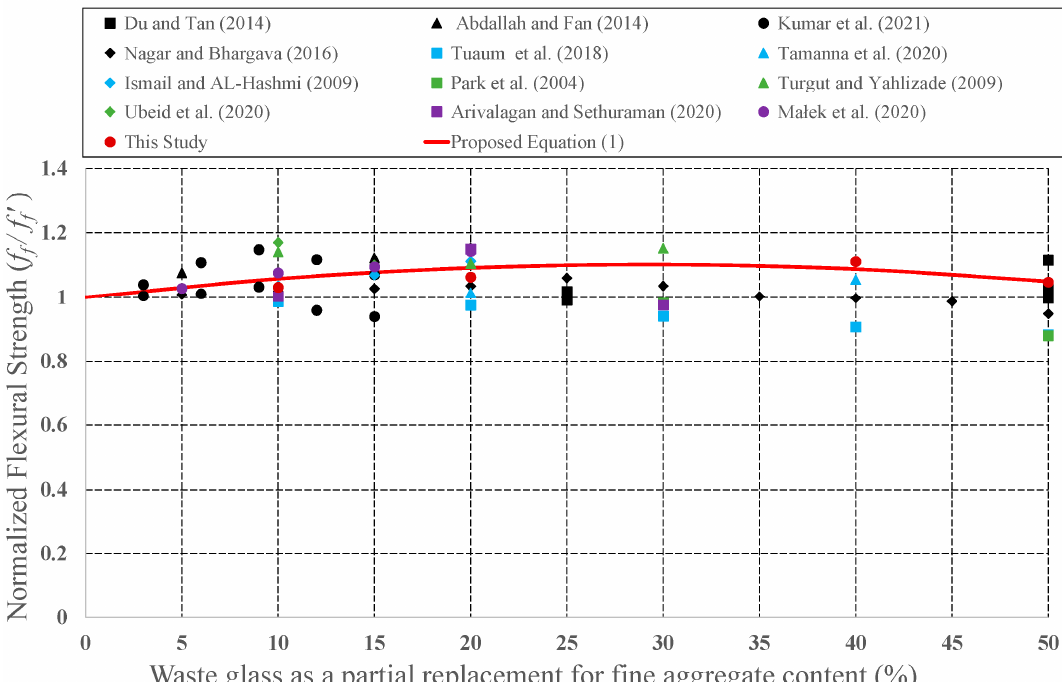
Figure 12. Discrepancy of the regulated Splitting tensile strength of the concrete produced with CWG as a partial replacement for FA [29,35,63,64,69,70,73,80].